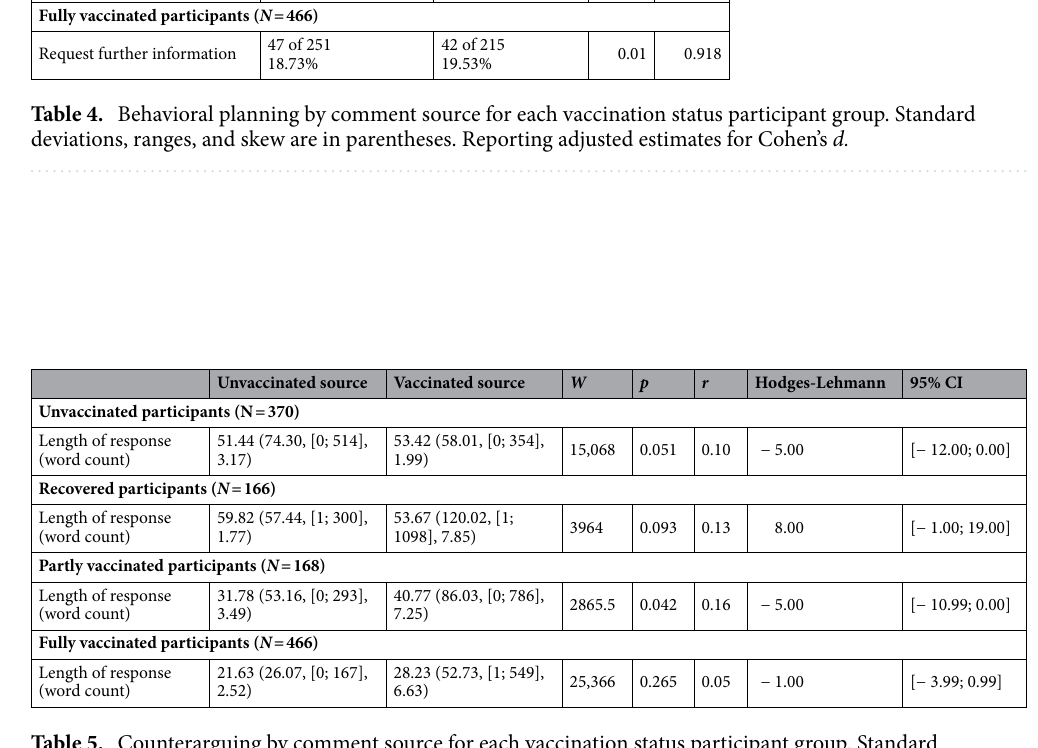
Table 5. Counterarguing by comment source for each vaccination status participant group. Standard deviations, ranges, and skew are in parentheses. Reporting adjusted estimates for Cohen’s